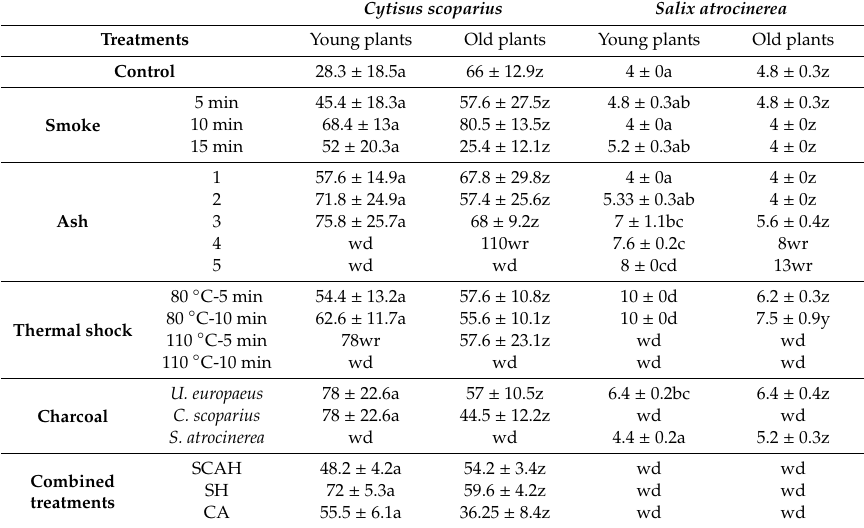
Table 2. T 50 (x ± sd) reached by C. scoparius and S. atrocinerea seeds of Old and Young mother plants under fire